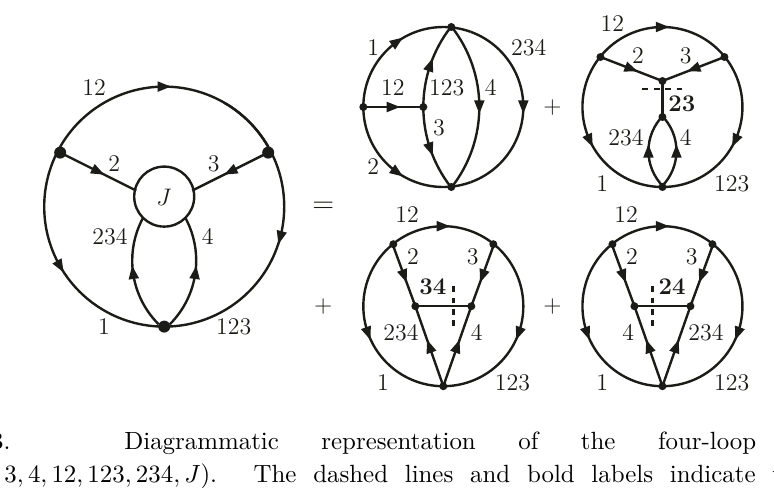
Figure 3 . Diagrammatic representation of the four-loop subtopology A (4) (1 , 2 , 3 , 4 , 12 , 123 , 234 , J ) . The dashed lines and bold labels indicate that propaga- N 4 MLT tors in the J -sets are set on shell in either of the two momentum